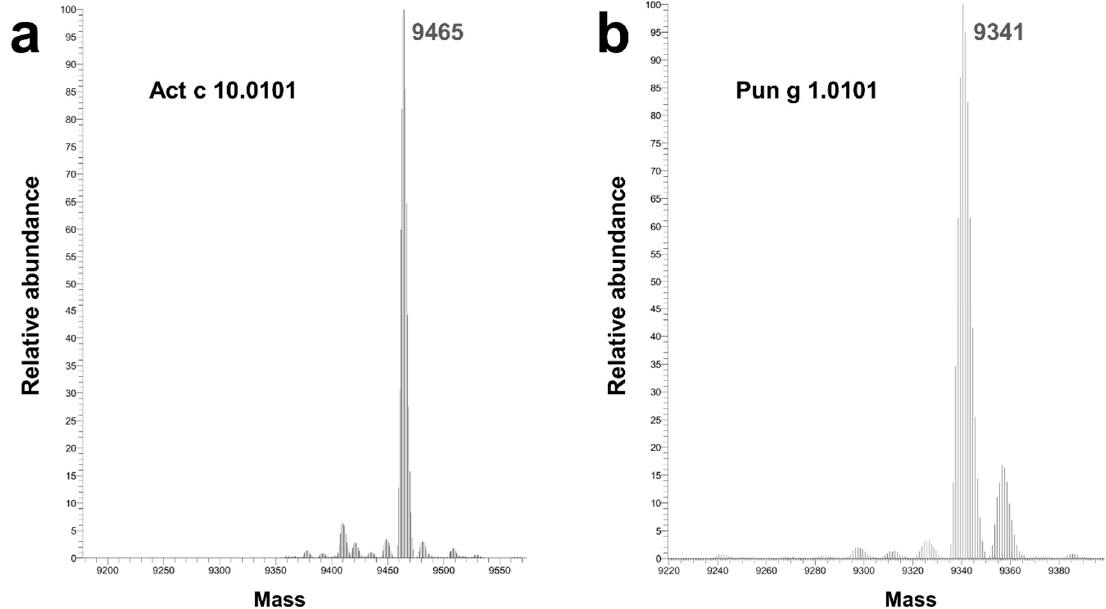
Figure 2 . Results of mass spectrometric analysis of ( a ) Act c 10.0101 and ( b ) Pun g 1.0101 samples used for crystallization experiments. Calculated molecular weights for Act c 10.0101 and Pun g 1.0101 that have intact disulfide bridges are 9453 and 9342 Da, respectively. When there is no formation of disulfide bridges, the calculated molecular weights are 9461 and 9350 Da for Act c 10.1010 and Pun g 1.0101, respectively.